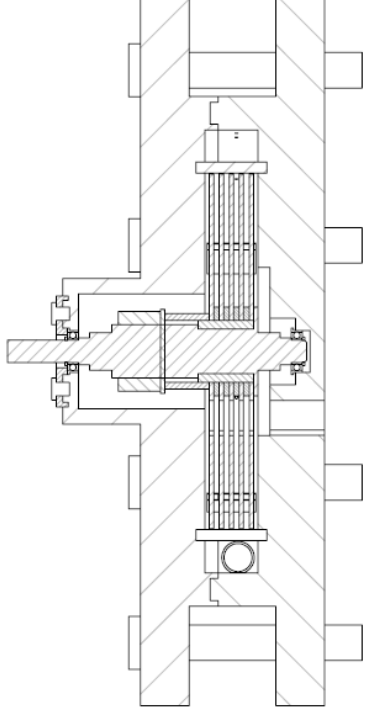
Figure 2. Cross-section of the turbine.